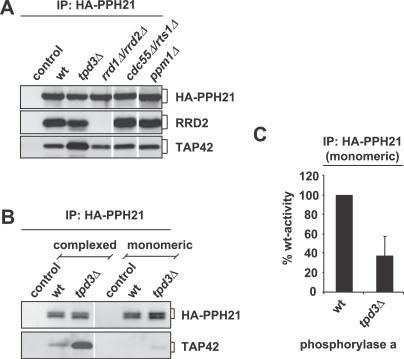
Decreased Catalytic Activity Is Intrinsic to the C Subunit(A) Anti–HA-tag immunoprecipitates from lysates of wild-type (wt) cells containing an empty vector (control) or wild-type, tpd3Δ, rrd1Δ/rrd2Δ, cdc55Δ/rts1Δ, and ppm1Δ cells expressing HA-tagged PPH21 were analyzed by SDS-PAGE and immunoblotting. The blots were sequentially incubated with specific antibodies against HA-tag, RRD2, and TAP42. Lanes 4–6 were not adjacent on the original blot.(B) Monomeric C subunits from the wild-type and the tpd3Δ strains were obtained by immunoprecipitation from lysates in which protein complexes had been disrupted by a basic pH shift, followed by neutralization (monomeric), or from control untreated lysates (complexed) (see Materials and Methods for details). The HA-PPH21 immunoprecipitates were analyzed by SDS-PAGE and immunoblotting.(C) An aliquot of the monomeric HA-PPH21 immunoprecipitates was tested by phosphatase assays towards phosphorylase a (n = 3).